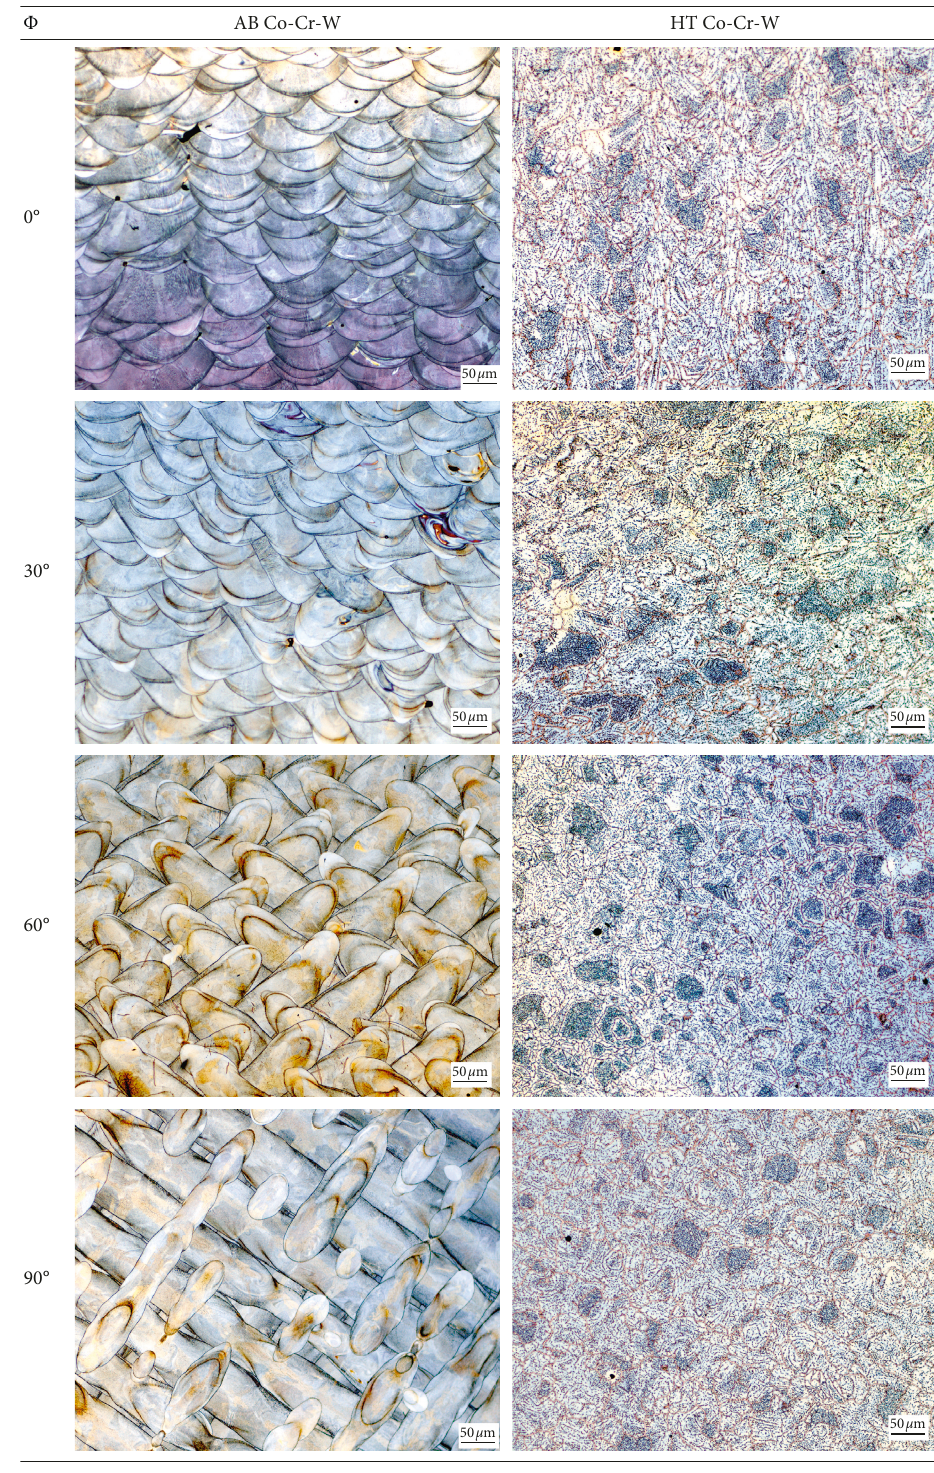
Figure 5: Microstructure (50 µ m) of AB and HT Co-Cr-W